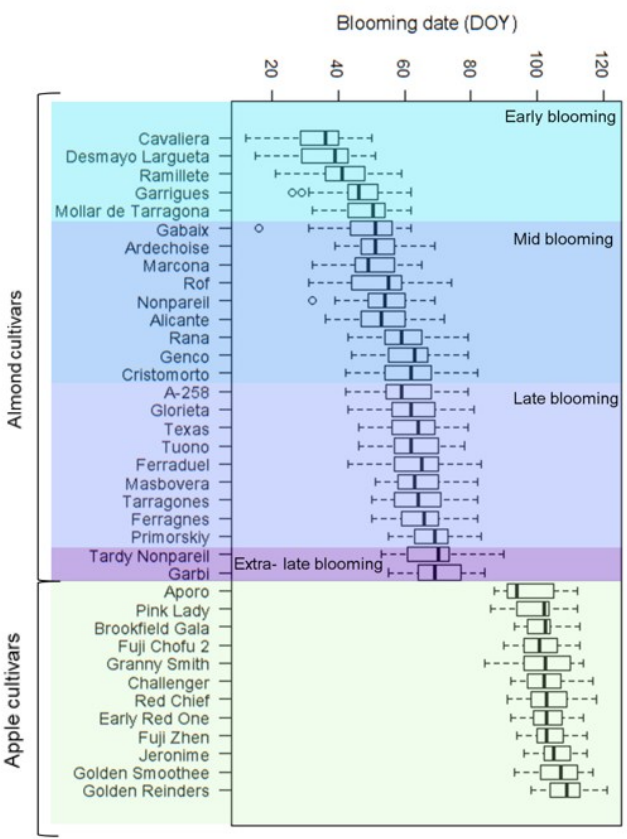
Figure 2. Statistical distribution of flowering date records (day of the year, DOY) of 25 almond cultivars cultivated in Mas de Bover from 1979 to 2015 and 12 apple cultivars cultivated in Mas Badia between 1992 and 2018. The left and the right part of each box are the first and third quartiles respectively, and the band inside the box is always the median. The ends of the whiskers represent standard deviation above and below the mean of the data. Small circles represent outliers. Almond cultivars are organized in early (turquoise), mid (blue), late (violet) and extra-late (purple) blooming time following the classification of Vargas and Romero [43]. Apple cultivars are represented in